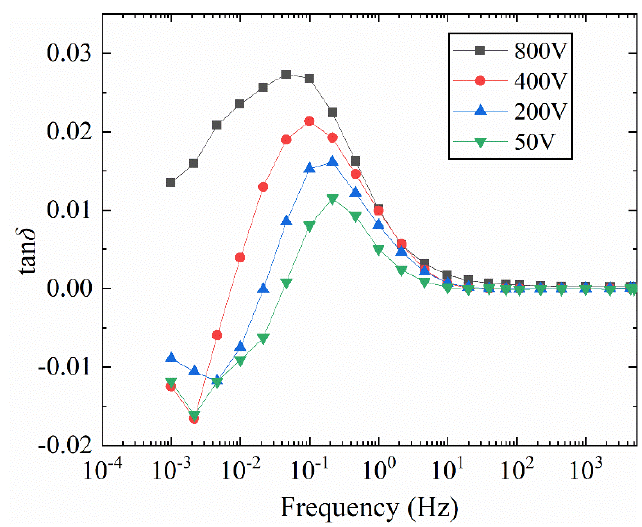
Figure 11. Influence of different wiring methods on the difference of tan δ - f curve of bushing model at different voltages (50 °C).